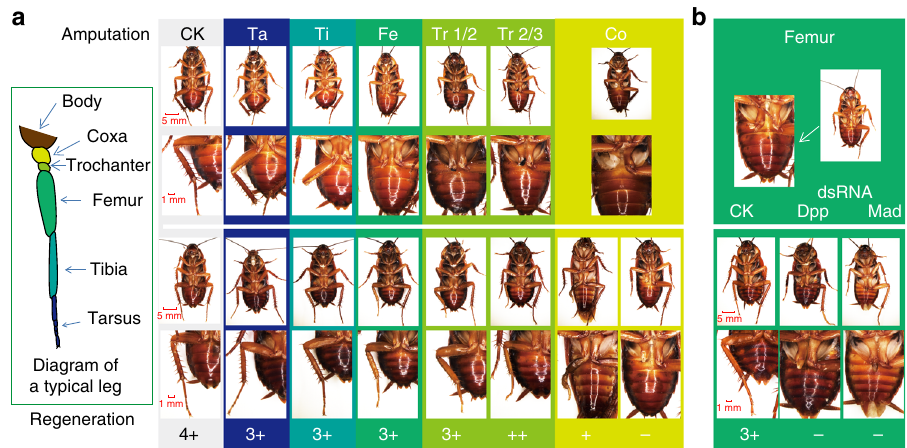
Fig. 5 Leg regeneration ability and its regulation by the decapentaplegic (Dpp) pathway in P. americana . a Limb regeneration con fi rmation under different trauma severity indices. The diagram in the box represents a typical leg with indicated parts in which we performed the amputation experiment. Regeneration ability is shown in the bottom, according to the wild-type size. 4 + , wild-type size; from 3 + to + , incomplete sizes; − , null. b Function of Dpp signaling pathway in leg regeneration. No leg regenerated ( − ) when Dpp and mothers-against-dpp ( Mad ) genes were knocked down by RNAi. CK, control dsRNA corresponds to that in Fig.